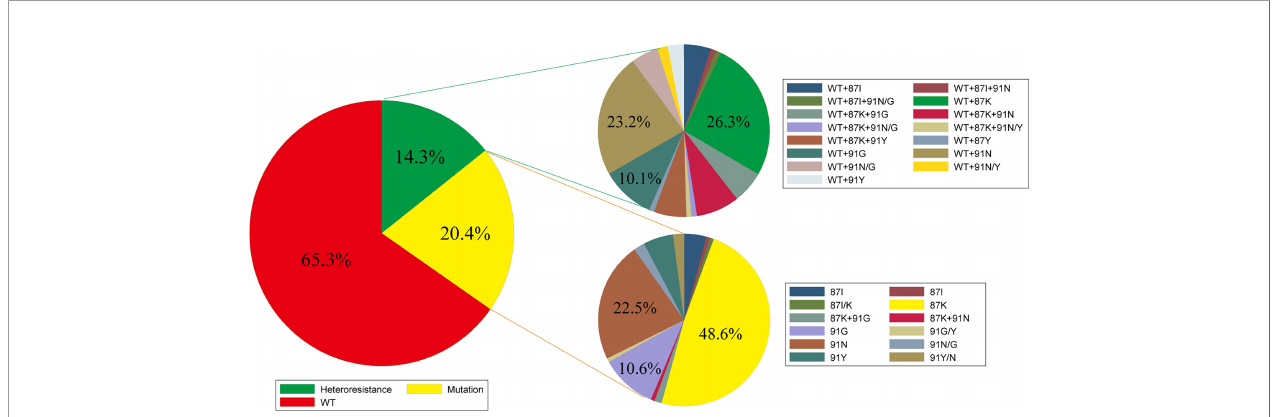
FIGURE 2 | Pro fi le of gyrA genotyping in gastric biopsies (WT, wild type; K, lysine; N, asparagine; Y, tyrosine; G, glycine; I, isoleucine; D, aspartate; 87K, the 87th amino acid was replaced by lysine; 91G, the 91st amino acid was replaced by